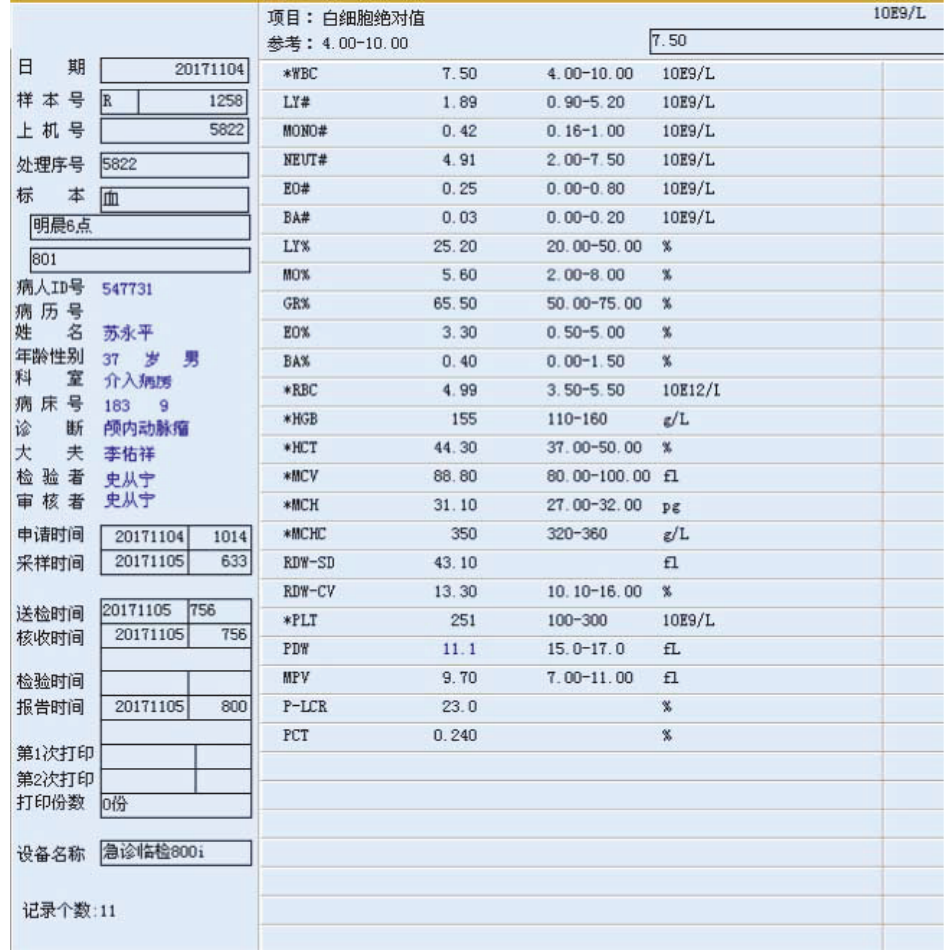
Figure 7: Postoperative blood routine